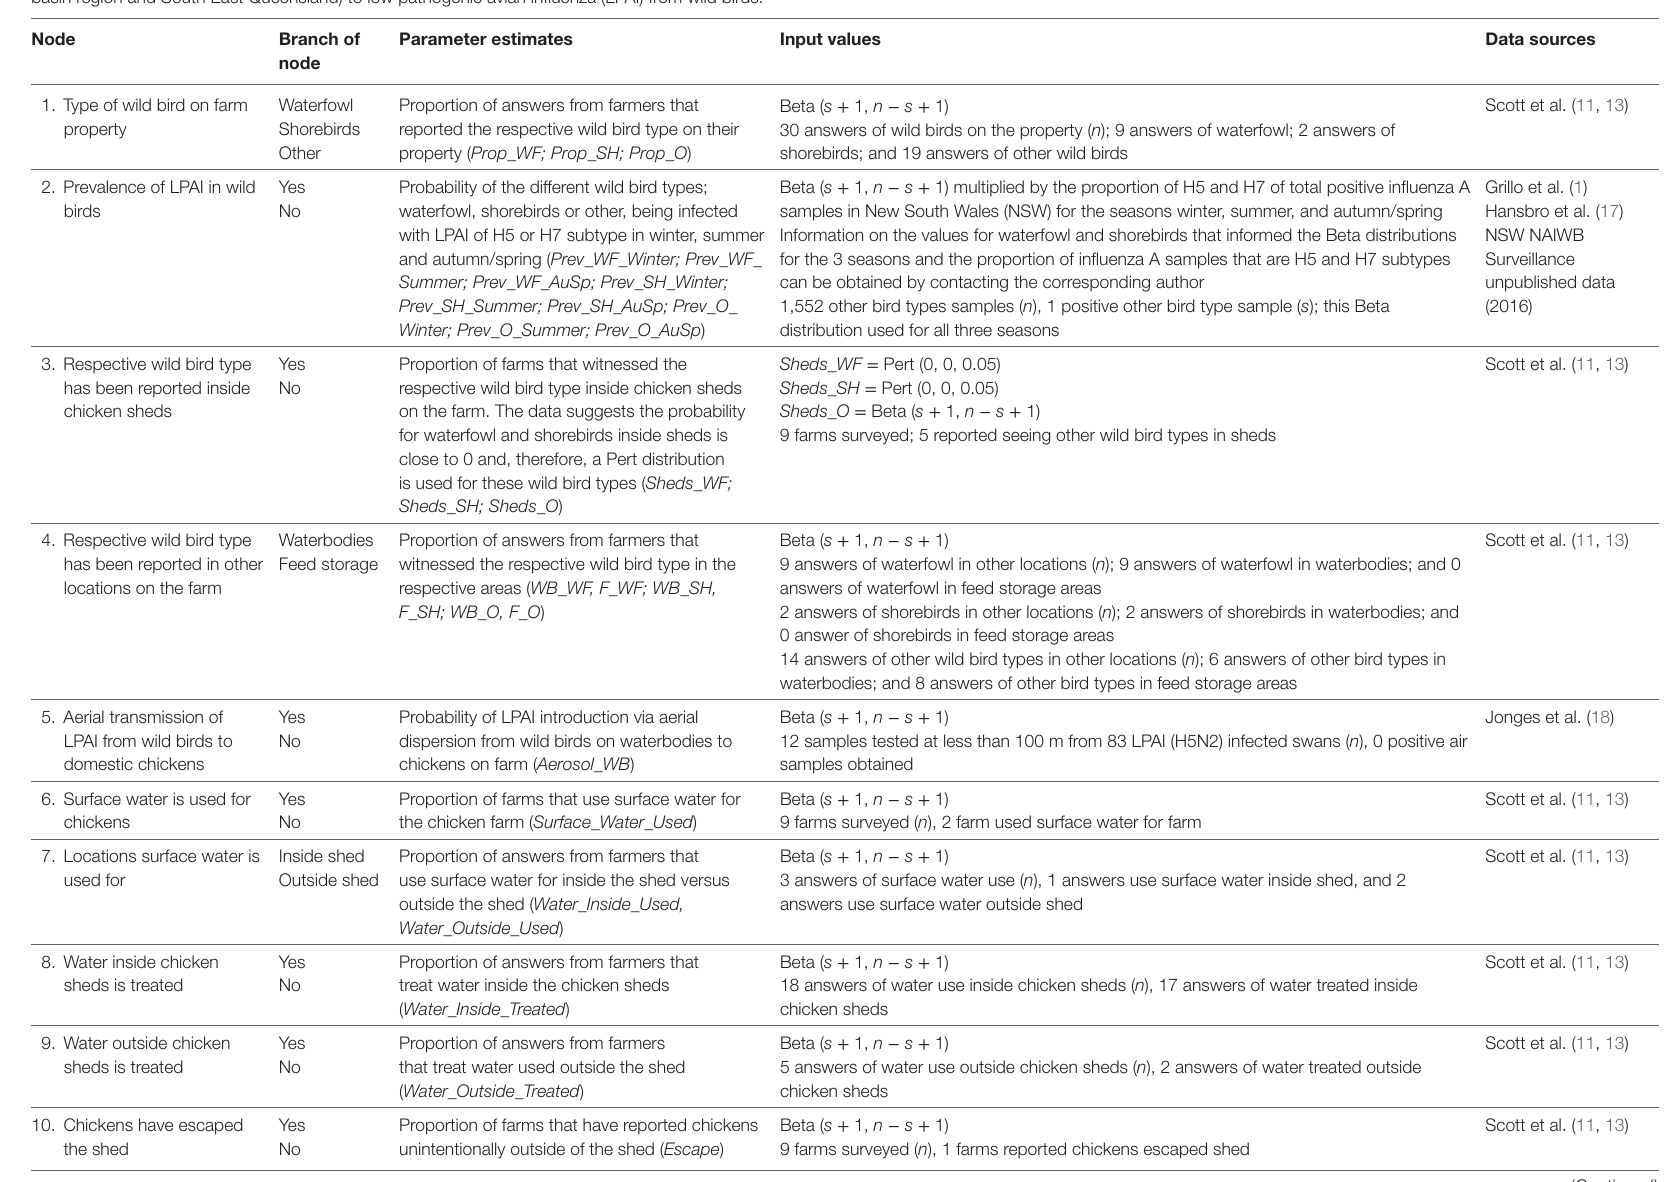
TaBle 3 | Nodes, parameter estimates and input values used for the exposure assessment estimating the probability of exposure of commercial chickens on cage layer farms in Australia (specifically in the Sydney basin region and South East Queensland) to low pathogenic avian influenza (LPAI) from wild